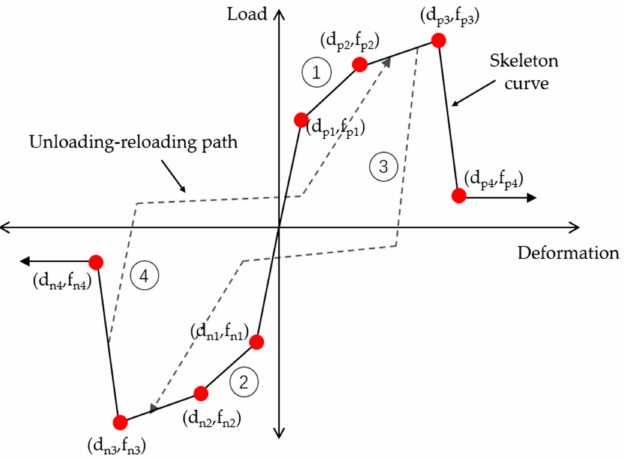
Figure 7. Generalized one-dimensional load–deformation hysteretic response